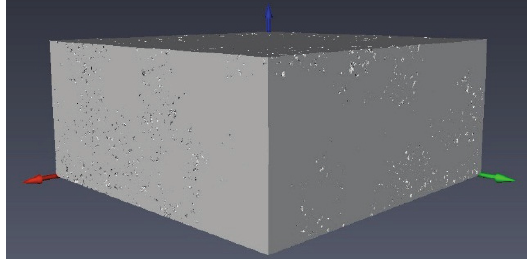
Fig. 2. Visualization of the sandstone (Carboniferous) skeleton, Avizo software, OGI-NRI in Cracow